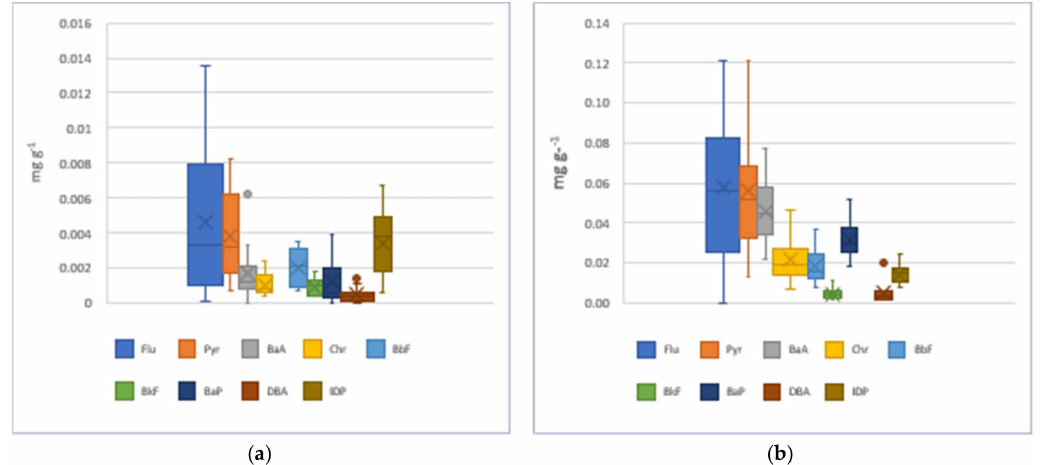
Figure 5. Distribution of individual PAH in PM 2.5 : ( a ) background samples; ( b ) RS burning samples. X marker in each bar chart: the mean of PAH content. Dash in each bar chart: the median of PAH